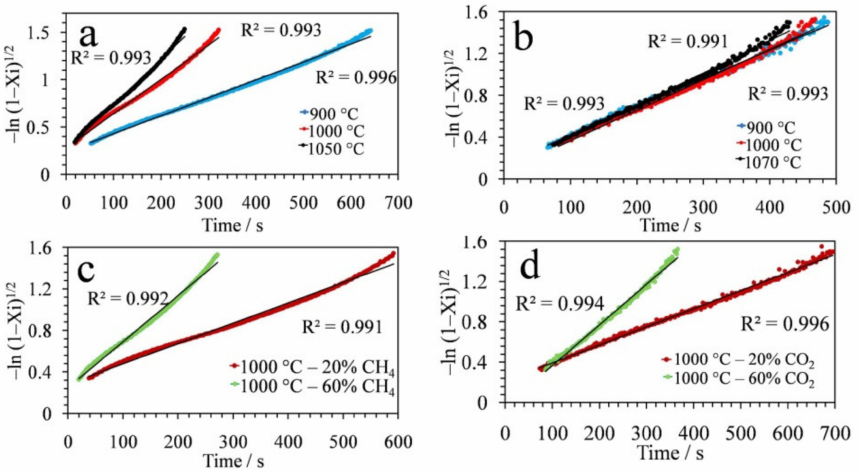
Figure 7. Comparison of experimental conversion data with 2D NGM (AE2) predictions for CeO 2 during ( a ) CH 4 -induced reduction at selected temperatures, ( b ) CO 2 -induced re-oxidation at selected temperatures, ( c ) varying CH 4 partial pressure during reduction, and ( d ) varying CO 2 partial pressure during re-oxidation. The partial pressure of the reactant gases was kept at 40% in ( a , b ). Experiments with varying partial pressures in ( c , d ) were carried out at 1000 ◦ C.